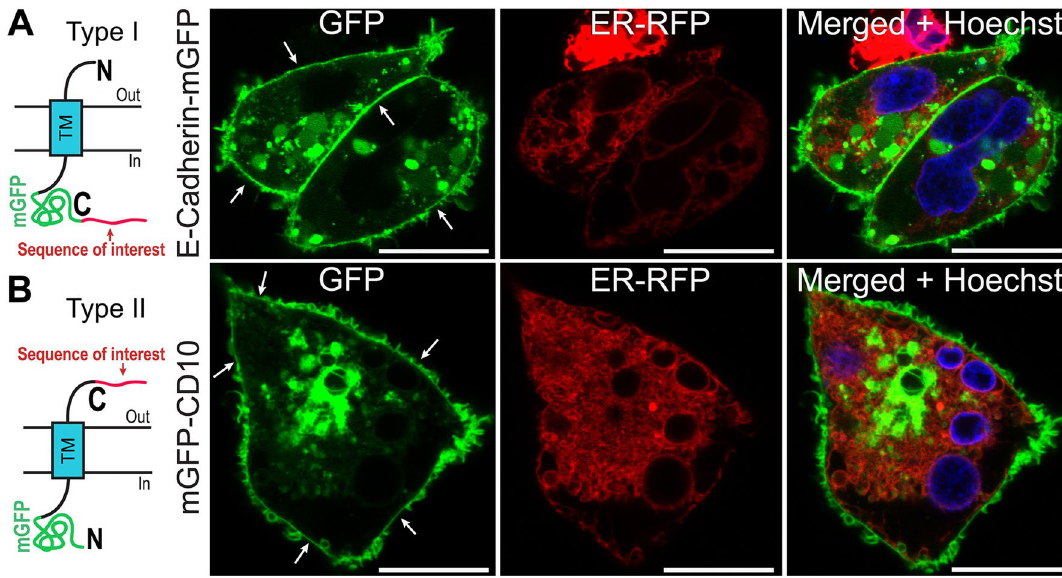
Figure 2. Employing E-Cadherin-mGFP- and mGFP-CD10-based reporters to test specific protein regions. ( A ) E-Cadherin belongs to the Type-I transmembrane family of proteins. E-Cadherin-mGFP (monomeric GFP) displays strong PM localization in transiently transfected HEK293 cells (white arrows), similar to the AGR system. E-Cadherin-mGFP reporter could be used to re-test intracellular loop domains and termini. ( B ) CD10 belongs to the family of Type-II transmembrane proteins. mGFP-CD10 shows intense PM localization in HEK293 cells. mGFP-CD10 reporter could be used to test extracellular loop domains and termini. Scale bars: 8